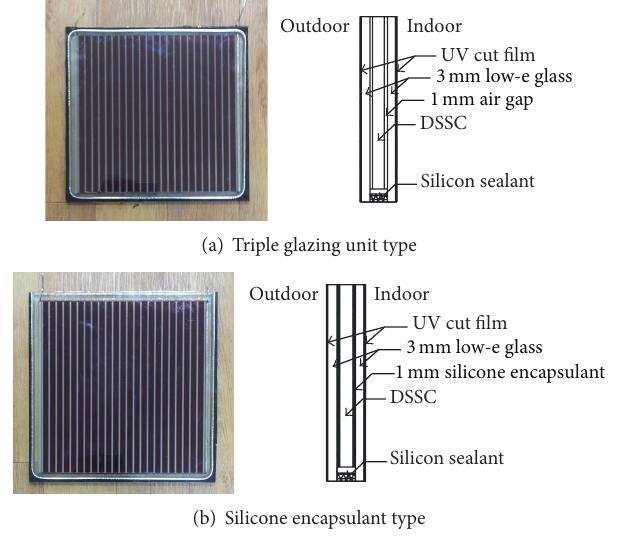
Figure 3: DSSC panel configurations. Table 1: DSSC panel structure.